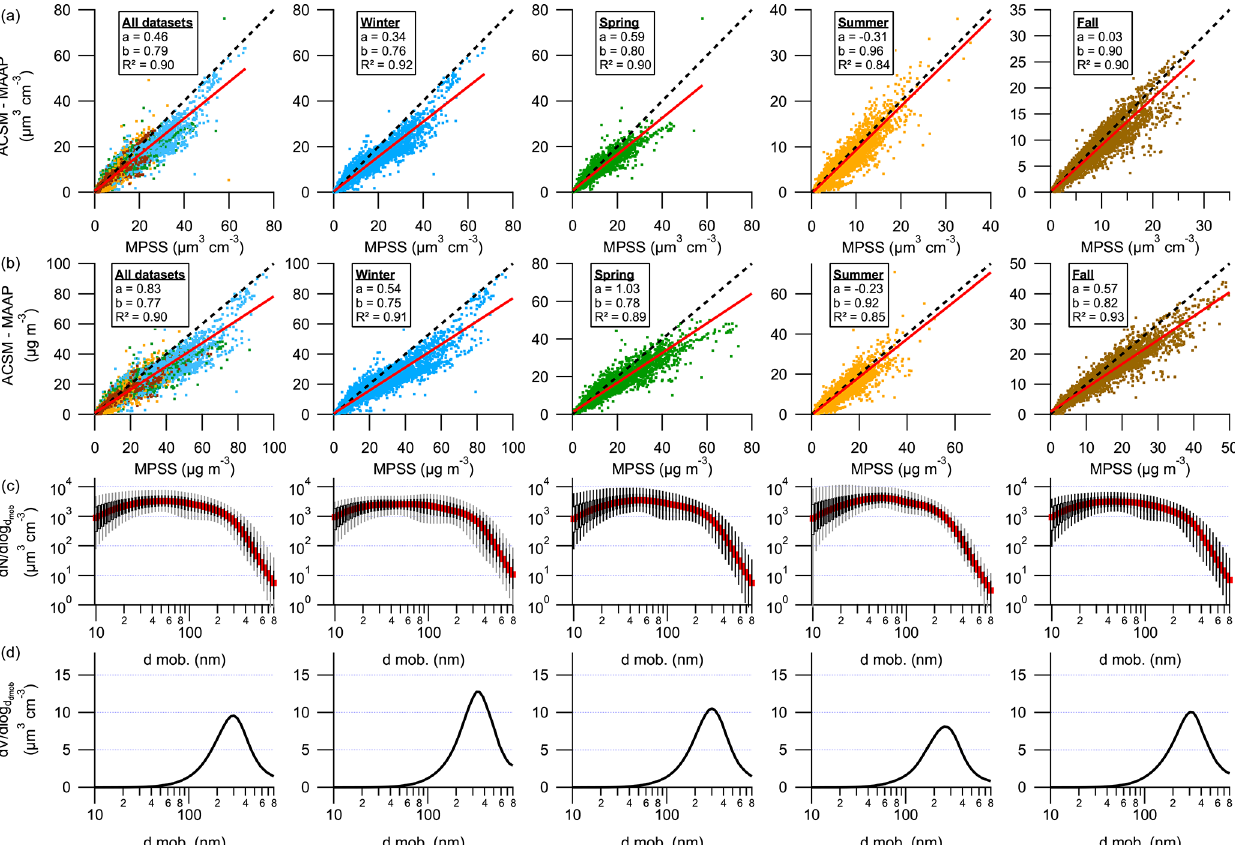
Figure 9. Comparison between measured ACSM–MAAP and MPSS for the entire period and seasonal variability: (a) volume closure, (b) mass closure, (c) median number size distribution (red) with 10–90 (grey line) and 25–75 (black boxes) percentiles, and (d) median volume size distribution. The linear regressions (red lines) were calculated using the least- orthogonal-distance fit